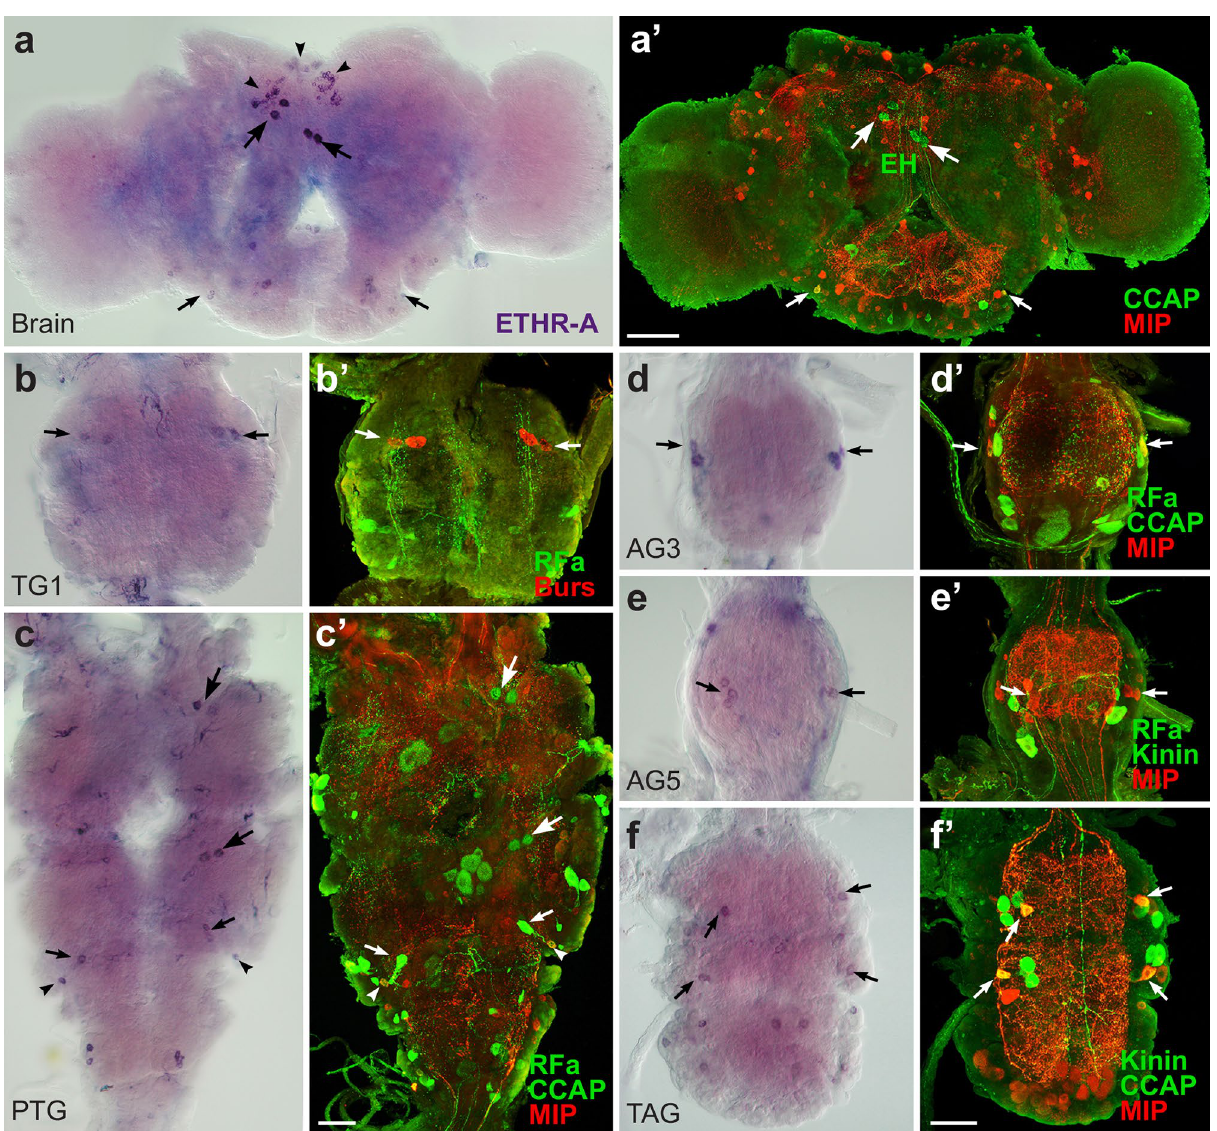
Figure 5. ETHR-A expression in the CNS of pharate adults. ( a–f ʼ ) Neurons identified by ISH with ETHR-A probe and subsequent staining of the same ganglia with various antibodies. ( a , a ʼ ) ETHR-A transcript in two pairs of VM cells producing EH (large arrows; green) and three clusters of small dorsomedial neurons in the brain (arrowheads). A pair of IN-704 producing ETHR-A in the SG stained with antibodies to CCAP and MIPs (small arrows; yellow). ( b , b ʼ ) NS-27 and IN-704 showing coexpression of ETHR-A and bursicon in the TG1 (arrows; red) and ( c , c ʼ ) the same neurons producing ETHR-A and CCAP in the fused TG2,3 (large arrows; green). ( c , c ʼ ) Colocalization of ETHR-A with CCAP in NS-27 (small arrows; green) and ETHR-A with CCAP and MIP in IN-704 (arrowheads; yellow) of the fused AG1,2. ( d–f ʼ ) ETHR-A expression in IN-704 producing CCAP and MIPs in the AG3-5 and TAG (arrows; red/yellow). ( f ) Note ETHR-A signal in additional neurons of the posterior TAG. Scale bars a,a´ = 100 µm, b-f´ = 50 to this peptide (n = 9) (compare with CCAP/MIPs effects below). These data indicate that AST-CC receptor is expressed or activated only several hours prior to the initiation of the ecdysis sequence. CCAP and MIPs produced by ETHR-A interneurons IN-704 act as proximal activators of the ecdysis behavior in M. sexta and D. melanogaster 7,8,32,33 . To determine if these neuropeptides control ecdysis in B. mori , we applied a mixture of CCAP (1 μM) and MIP-I-VII (3 μM total) to the isolated desheathed CNS (n = 8). As expected, the mixture induced clear and characteristic ecdysis bursts within 1–3 min in all ganglia AG1-7 (Fig. 11g). In contrast to AST-CC, neuropeptides CCAP and MIPs activated normal ecdysis motor program in the desheathed CNS of early pharate or feeding 5th instar larvae (n = 7; Fig. S3). Washout of CCAP and MIPs waned the ecdysis activity, whereas repeated applications of the mixture on the same CNS restored normal ecdysis bursts. CCAP alone was less effective and induced clear ecdysis patterns only in the anterior ganglia AG1-3, whereas posterior ganglia AG5-7 showed either noisy bursts or no discernable rhythmic activity (n = 4). Application of MIP-I only